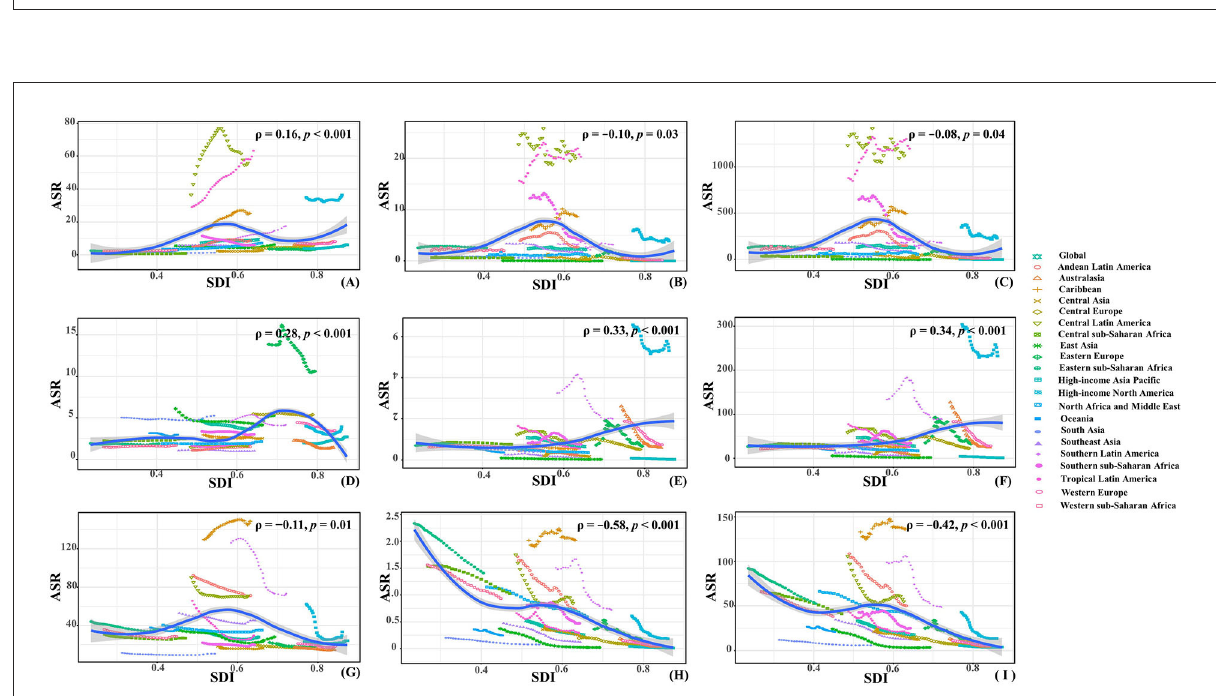
FIGURE4 The associations between ASRs and SDI among regions. (A–C) were that of incidence, death, and DALYs of PVF; (D–F) were that of death, and DALYs of SHF; (G–I) were that of incidence, death, and DALYs of UFI, respectively. The association was calculated with Pearson correlation analysis. PVF, physical violence; SHF, self-harm by firearm; UFI, unintentional firearm injuries; ASR, age-standardized rate; SDI, sociodemographic index; DALYs: disability-adjusted life